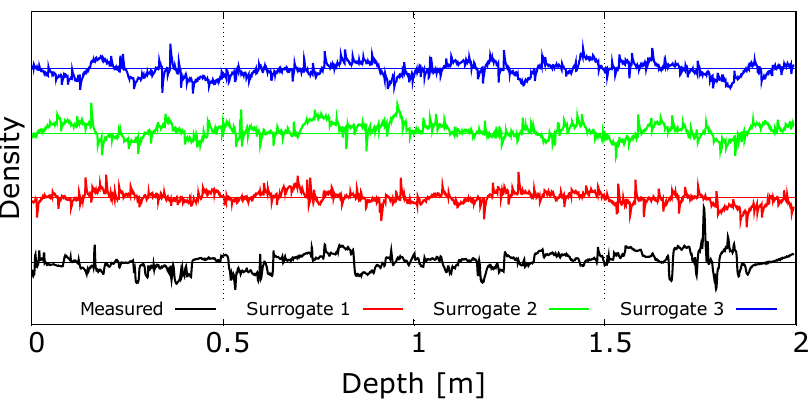
Figure 8. The measured density profile and three surrogates for the first site (NEEM). The artificial profiles are based on the seasonal δ 18 O component of the density and have the same statistical properties as the original curve. Each profile is displayed at the same scale and has been centered around its mean.